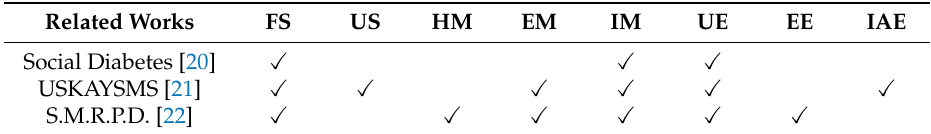
Table 13. Related works in terms of usability